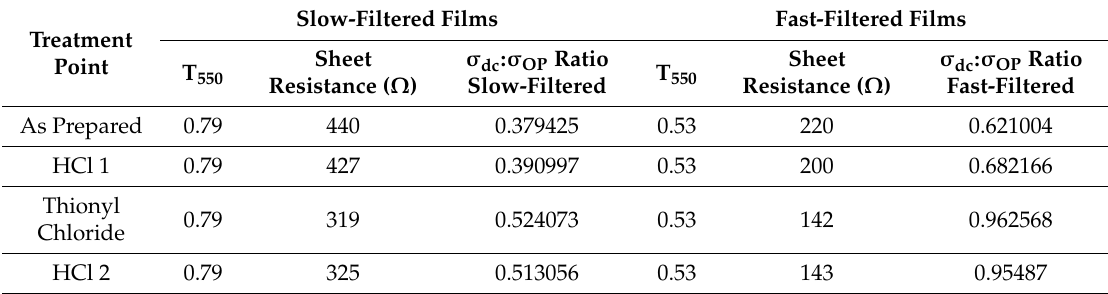
Table 3. σ dc : σ OP ratio calculations for slow and fast films used in solar device production. Note that HCl was used in lieu of HF as HF would have dissolved the glass on which the CNT films were attached.